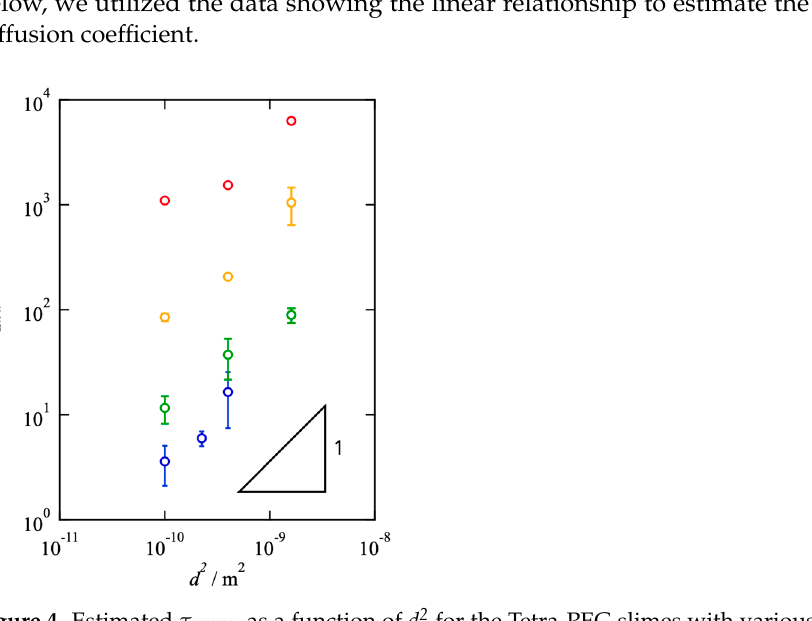
Figure 4. Estimated τ KWW as a function of d 2 for the Tetra-PEG slimes with various s (red: s = 0.5, yellow: s = 0.4, green: s = 0.3, blue: s = 0.2).